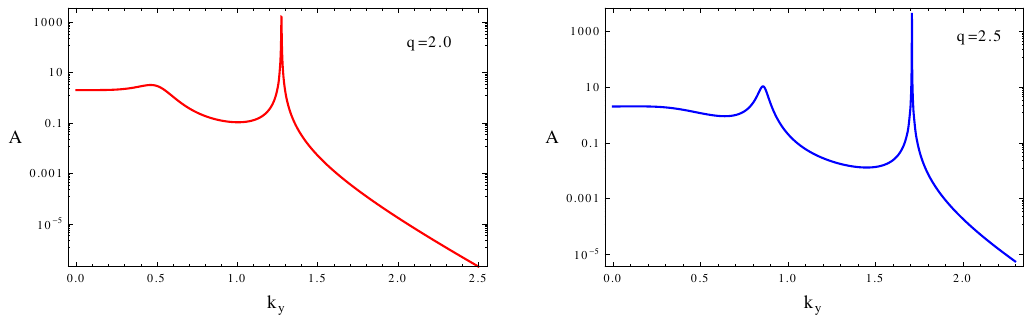
Figure 3 . Top: momentum distribution of the spectral density (MDF) as a function of k y for (cid:12)xed k x = 0 and varying values of q . Bottom: the 3D plots of the spectral density in momentum space ( k x ; k y ) for q = 0 : 8 and q = 1. We choose ! = 10 (cid:0) 6 and work with the background geometry shown in (cid:12)gure 1.